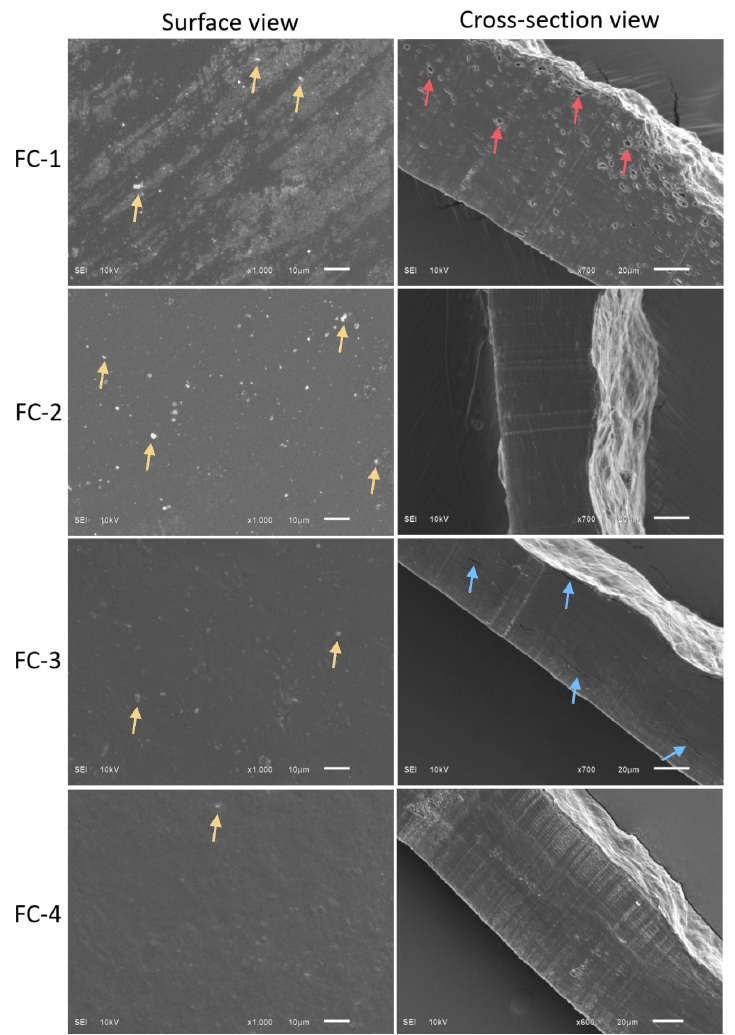
Figure 4. SEM of the CS–SA composite films: control or FC-1, CS+ SA; FC-2, CS+ SA+ FFE (0.5%); FC-3, CS+ SA+ FFE (1%); and FC-4, CS+ SA+ FFE (1.5%). The colour of the arrows presents different properties; yellow indicates particles, red indicates pores, and blue indicates cracks.